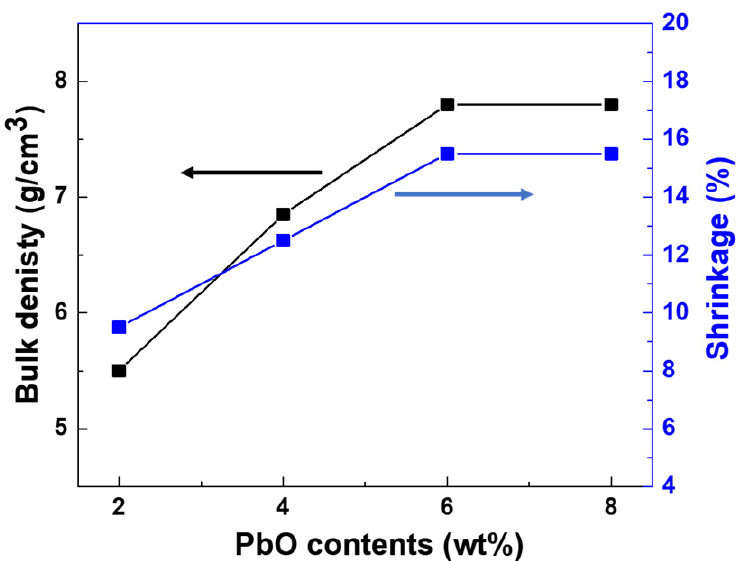
Figure 2. Densities and shrinkages of sintered bodies at 950 °C according to the addition of PbO in the PLZT + ZnO (2.5 wt%) composition.